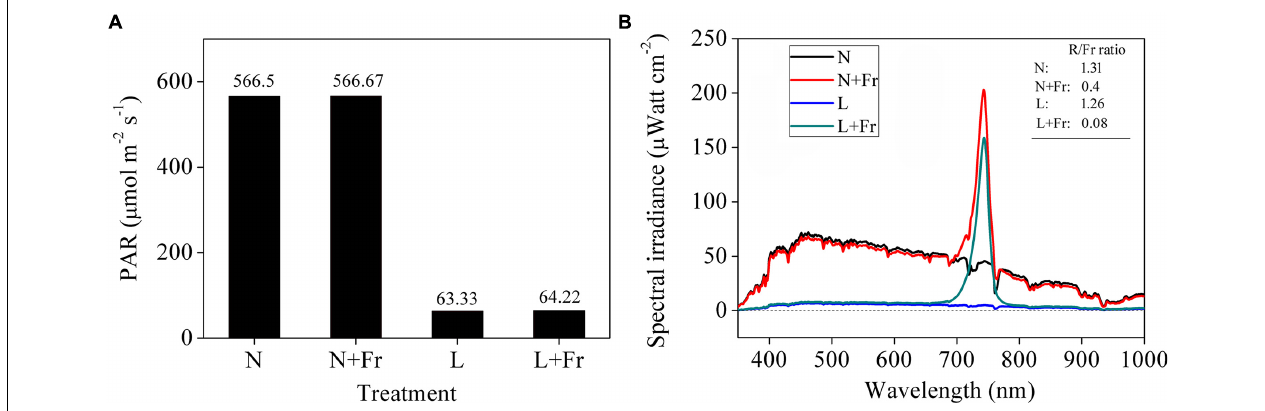
FIGURE 1 | Light intensity (A) and quality (B) of soybean canopy under different treatments. N, N+Fr, L, and L+Fr denote normal light, normal light plus far-red light, low light, and low light plus far-red light,